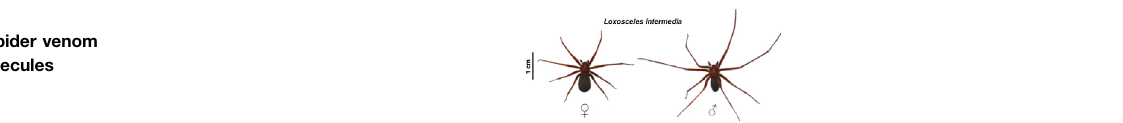
TABLE 2| Summarization oftheprotein contentof Loxosceles spiders ’ venoms — classesoftoxinsand potential applicationsofthese molecules tomanagetheloxoscelism and to develop drugs and biological/biotechnological inputs.